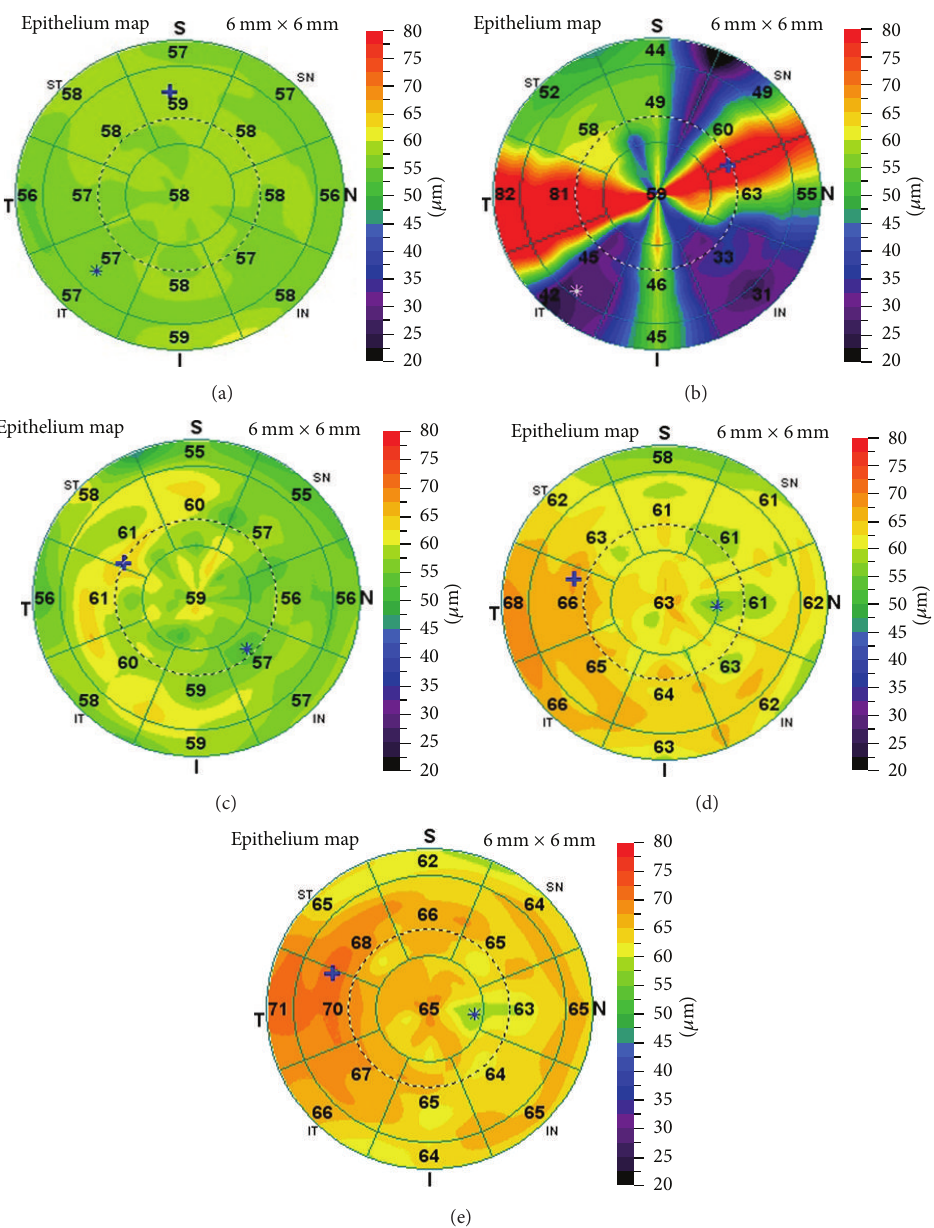
Figure 2: Epithelial thickness profile mapping seen preoperatively (a) and 1 week (b), 1 month (c), 3 months (d), and 6 months (e) postoperatively in a T-PRK examination. The patient (right eye) received treatment for − 4.75 D. the change in anterior corneal contour after laser ablation stimulates epithelial thickening